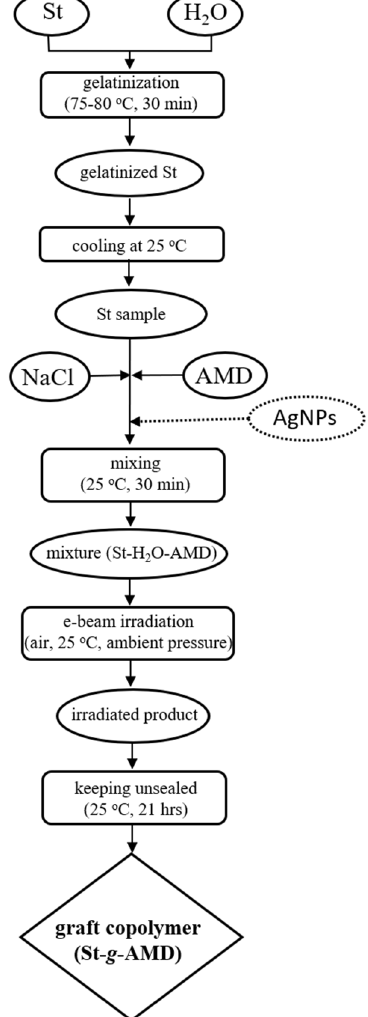
Scheme 1. Synthesis of graft copolymers by using electron beam